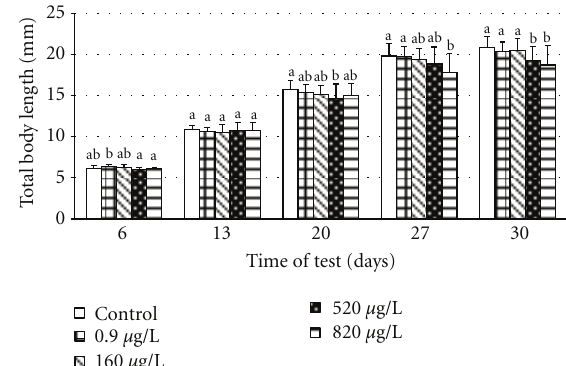
Figure 1: Total body length of common carp during the embryolar- val toxicity test (mean ± SD; (a, b) groups with di ff erent alphabetic superscripts di ff er significantly ( P < 0 . 05); day 6, 13, and 27 n = 75; day 20 n = 150; day 30 n = 225).